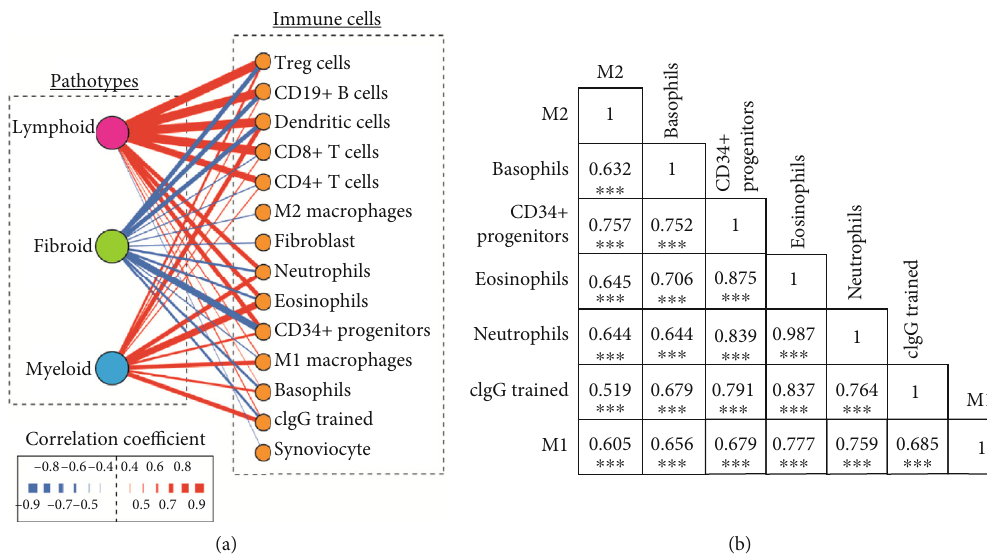
Figure 6: Correlation of RA synovial pathotypes with immune cells. (a) The relationship between the three RA synovial pathotypes, i.e., lymphoid, fi broid, and myeloid, and immune cells, represented by nodes. The interaction pro fi le is shown in the links (lines) between the nodes, and the strength is highlighted by the thickness of the lines and the color. Red and blue lines indicate positive and negative correlations, respectively. (b) Correlation matrix for M1, M2, cIgG-trained monocytes, neutrophils, eosinophils, basophils, and CD34+ progenitors. Pearson correlation coe ffi cients are indicated. ∗∗∗ P < 0 : 001